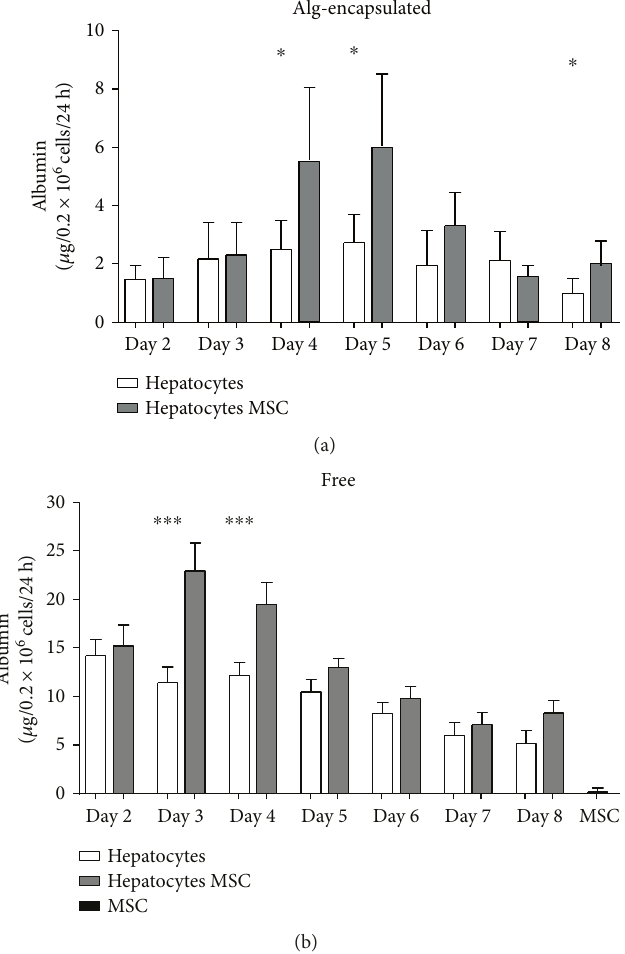
Figure 7: Albumin secretion of hepatocytes coencapsulated and cocultured with MSC. Albumin secretion was measured by ELISA in the supernatant of cell culture after 24 hours from day 2 to day 8. (a) Alg-microencapsulated hepatocytes alone (white bars) or with MSC (grey bars), measured in 2 independent experiments. (b) Free hepatocytes alone (white bars) or with MSC (grey bars), measured in 5 independent experiments. ∗ p < 0 05 , ∗∗∗ p < 0 001